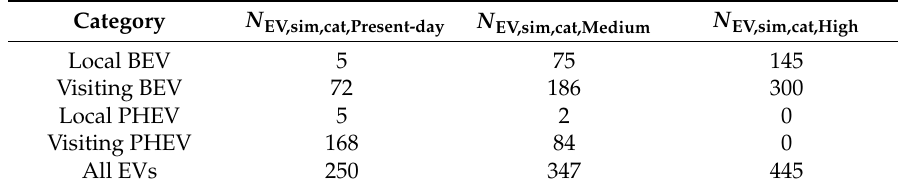
Table 2. Number of unique EV identities (IDs) occurring in the simulation for the different EV categories and scenarios for EV fleet size, per EV